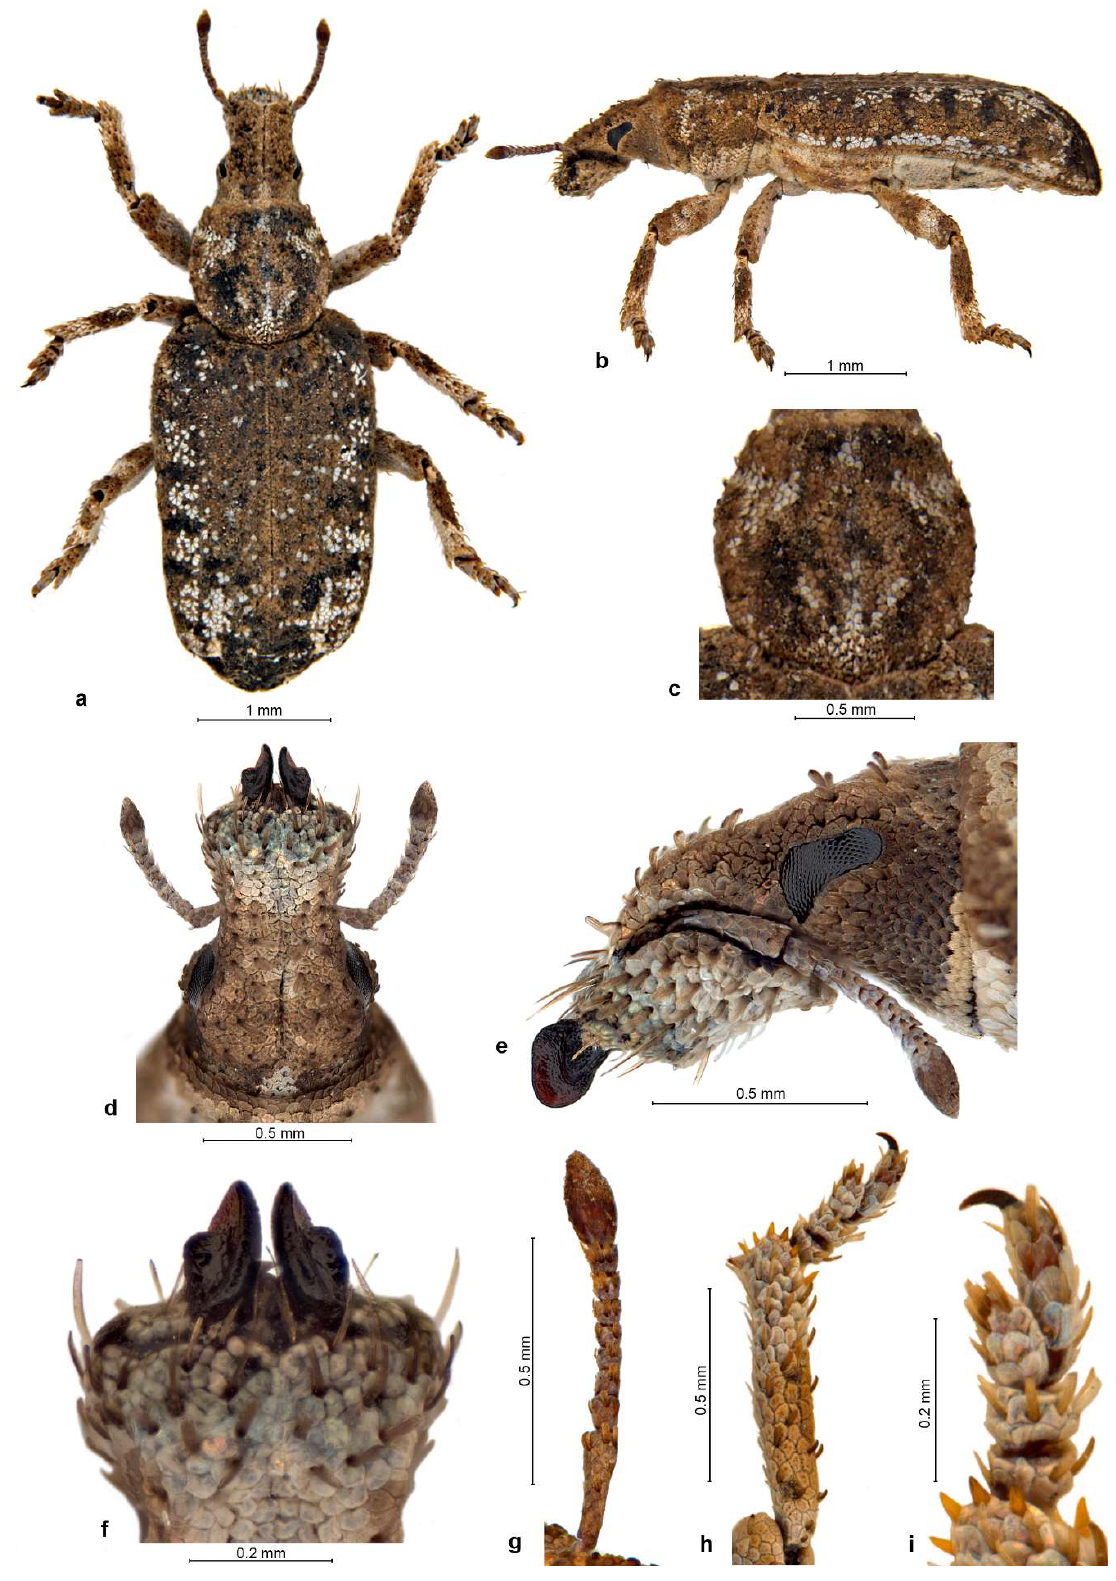
Figure 4. Philetaerobius louwi sp. n. ( Us Pass), ♂ —dorsal habitus ( a ); left lateral habitus ( b ); pronotum, dorsal view ( c ); head, dorsal view ( d ); head, lateral view ( e ); rostrum and mandibular cusps, dorsal view ( f ); right antenna, dorsal view ( g ); right protibia and -tarsus, dorsal view ( h ); right protarsus, lateral view ( i ).